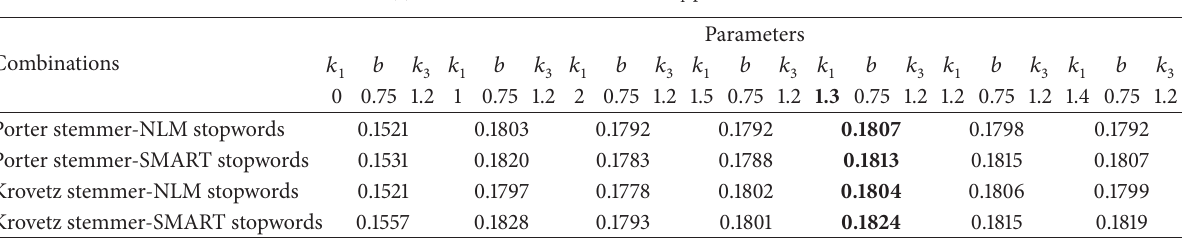
Table 5: Testing values of the parameters for BM25. MAP is used as the evaluation measure. (a) The best value obtained for the 𝑘 1 parameter